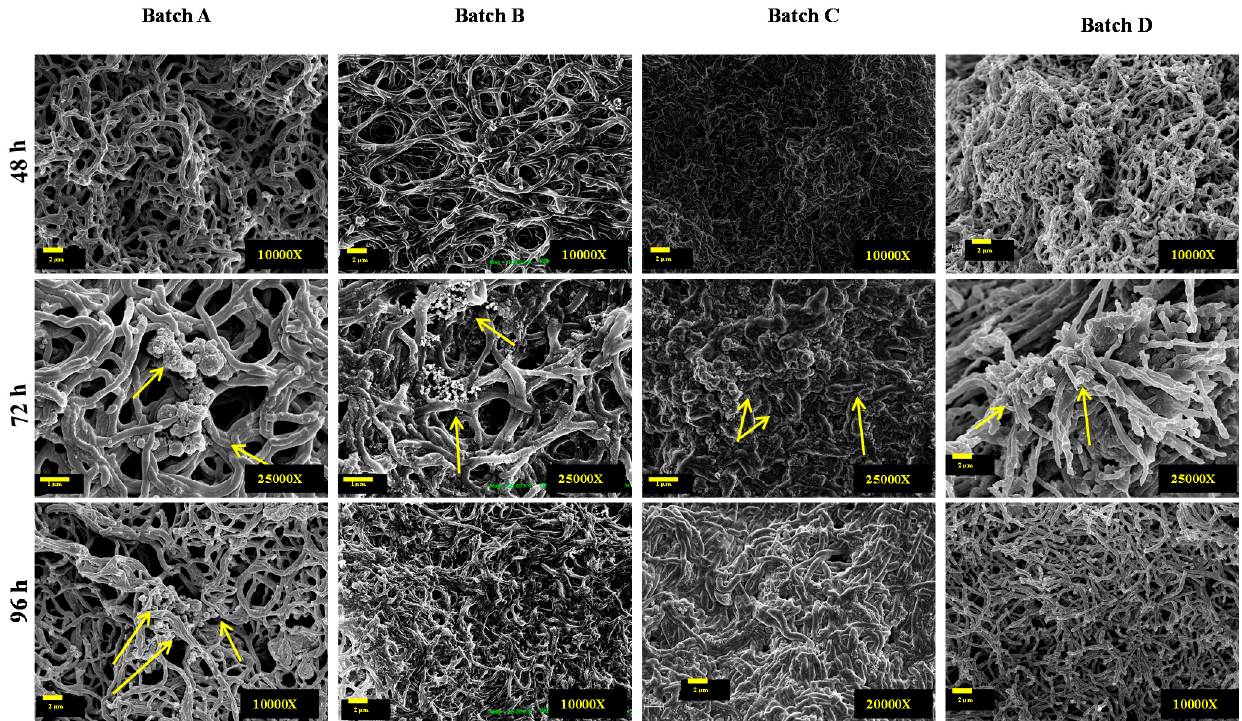
Figure 4. SEM analyses of Streptomyces albus -pAPI biomass samples of the different batch experiments at different time points. Deposits on the mycelium surfaces are indicated by the arrows.